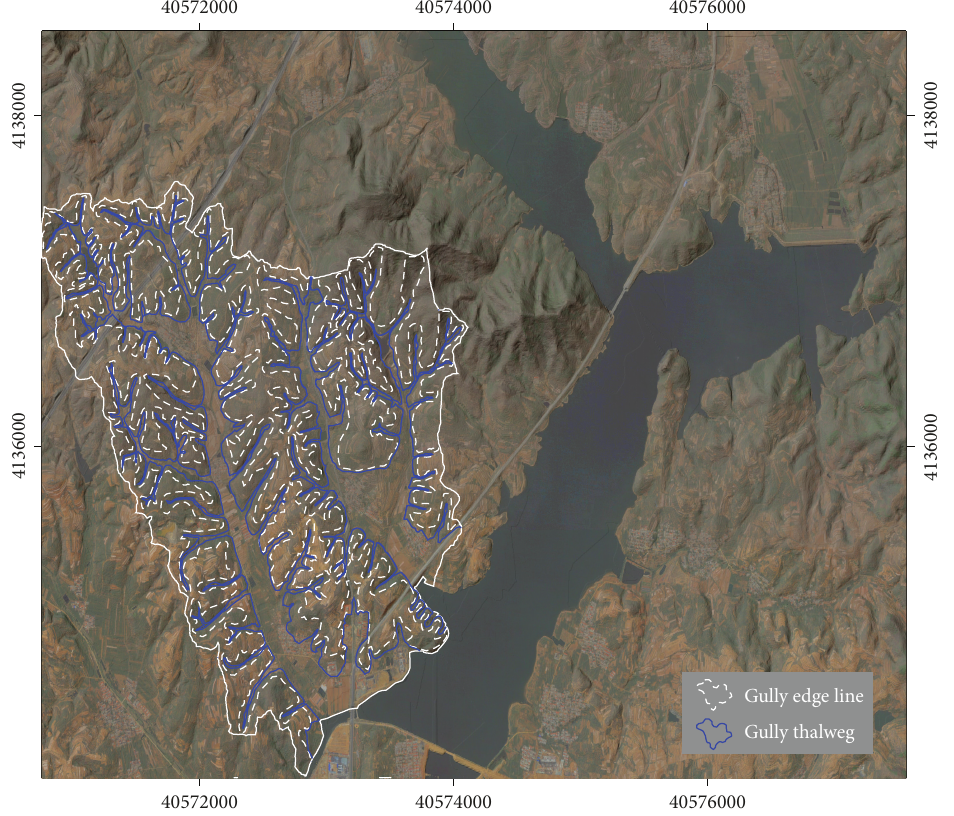
Figure 3: Results of fusing Quickbird image and Northwest